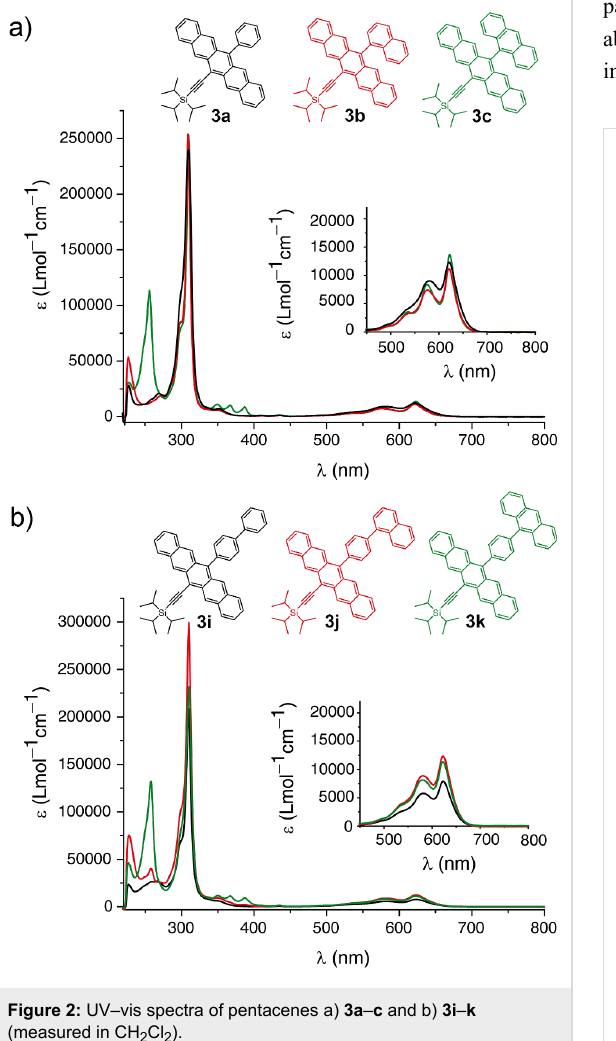
Figure 2: UV–vis spectra of pentacenes a) 3a – c and b) 3i – k (measured in CH 2 Cl 2 ).